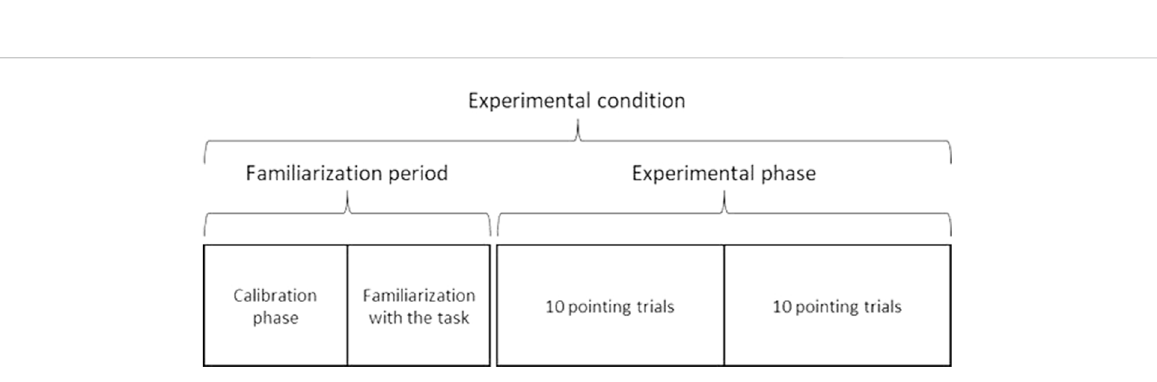
FIGURE 5 For the three experimental conditions, the experiment was composed of a familiarization period followed by an experimental phase. The familiarizationperiodwassplitintoacalibrationphaseandafamiliarizationwiththetask.Thecalibrationphaseconsistedof2 minutesoffreewalking in the environment. It was designed to allow participants to become familiar with their displacement in the VR environment. The familiarization with